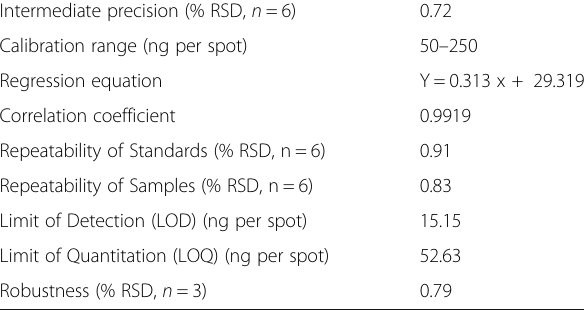
Table 1 Validation data of HPTLC method for the estimation of glangin